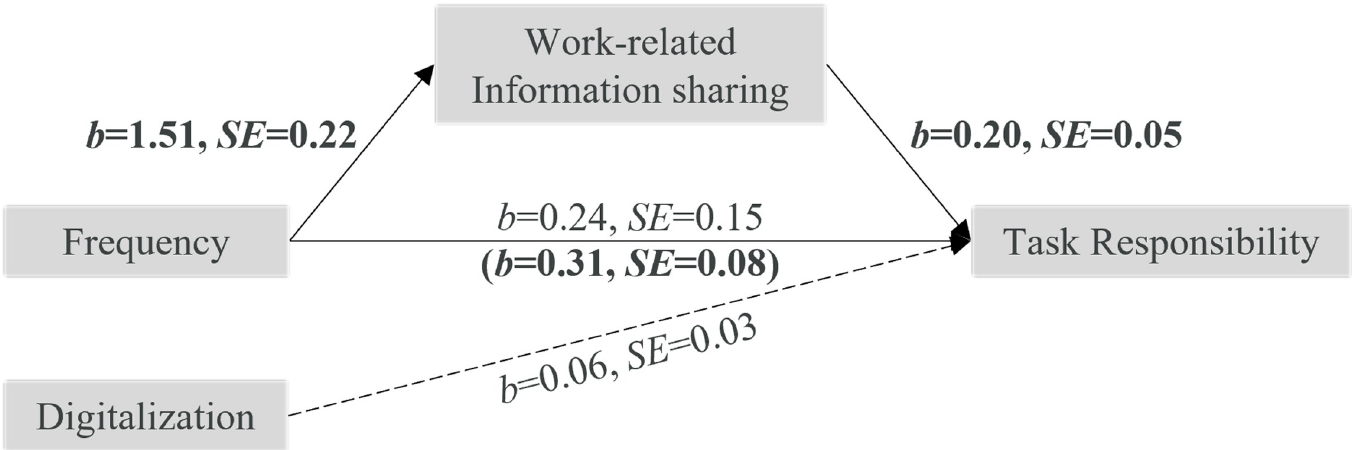
Fig 5. Mediation analysis with outcome perceived task responsibility. Estimates in bold are significant, dashed line represents control